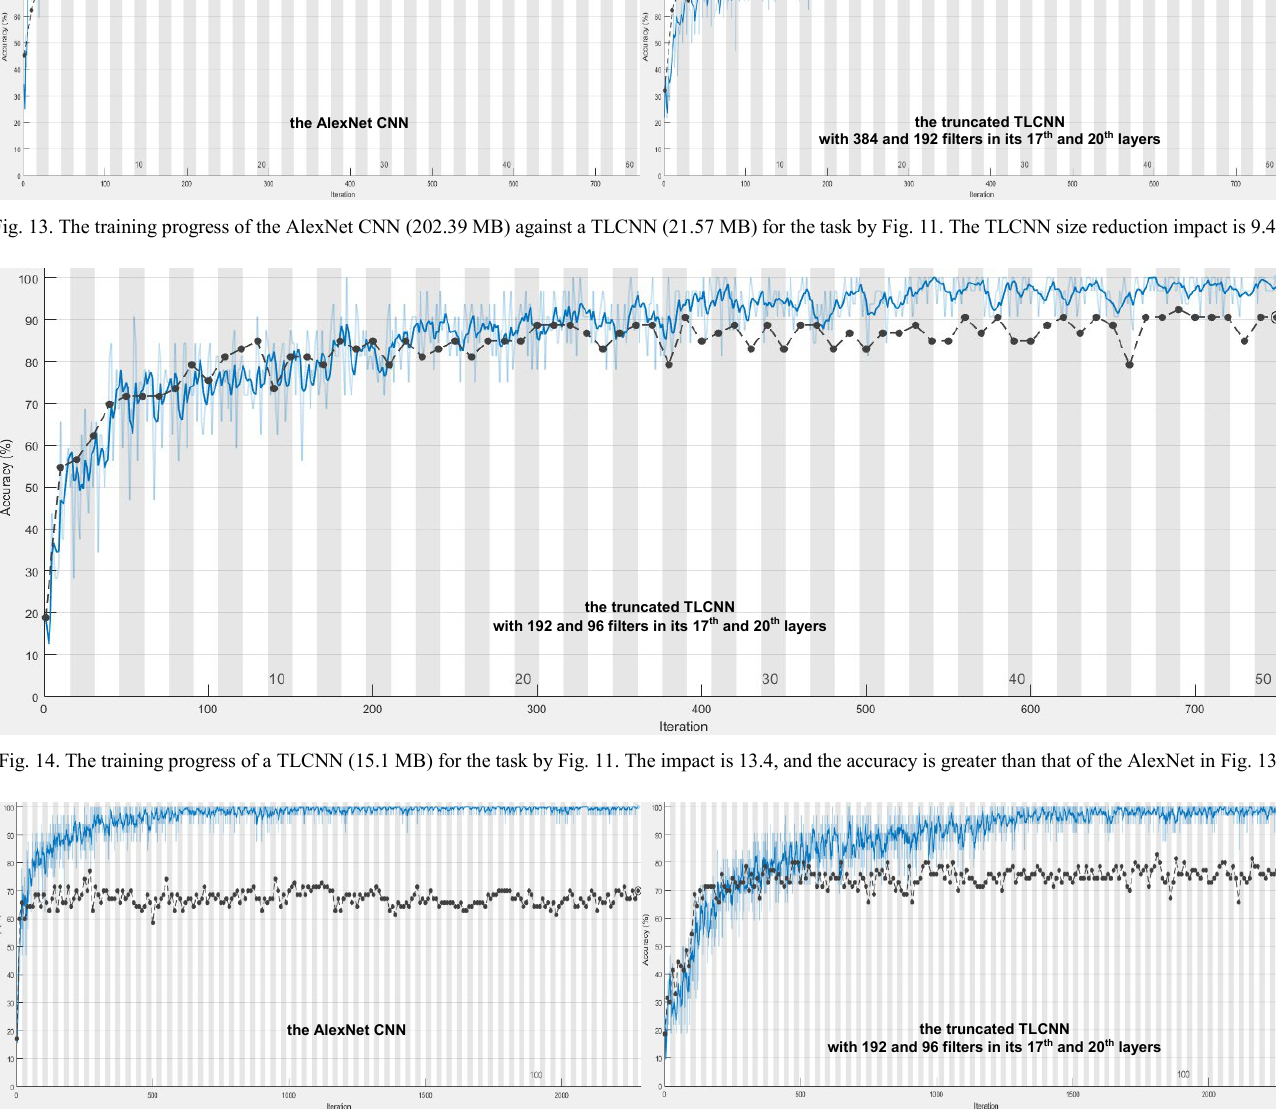
Fig. 15. The training progress of the AlexNet (202.48 MB) against a TLCNN (15.11 MB) for the task by Fig. 12. The impact is 13.4 at the improvable